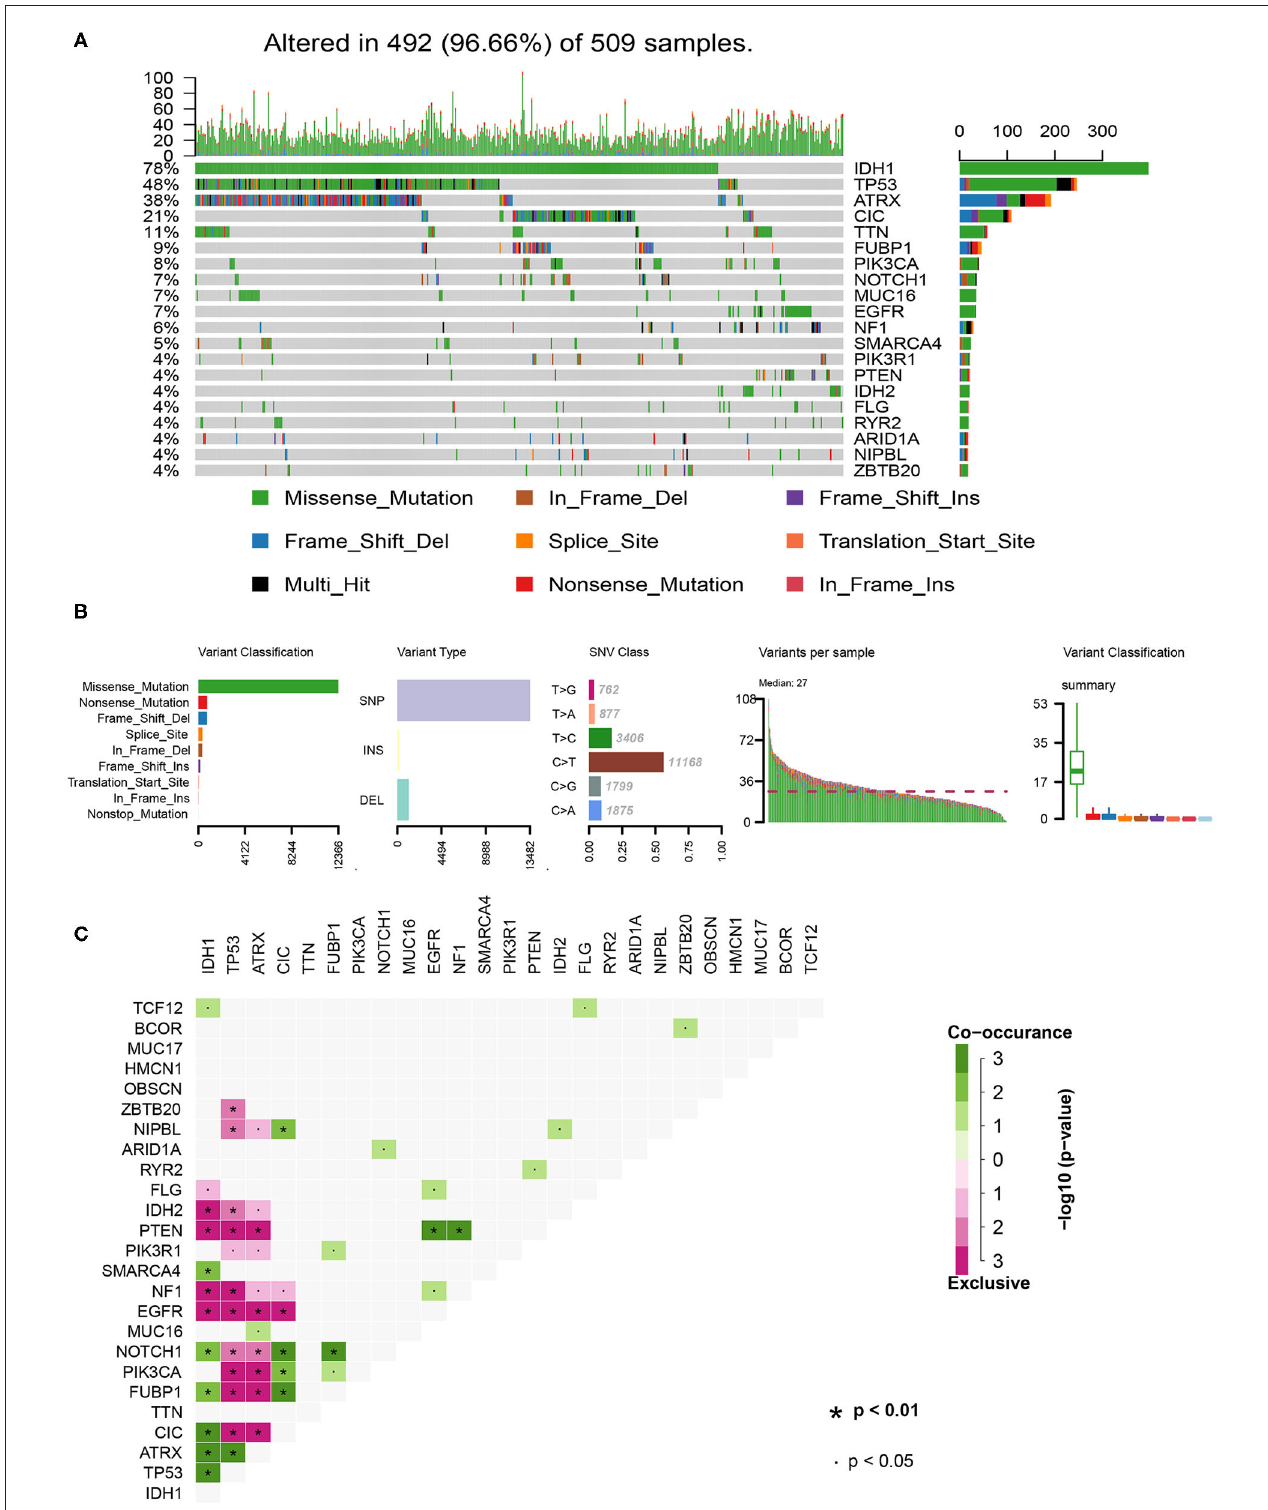
FIGURE 1 | Summary of the of LGG mutation information. (A) Landscape of mutation profiles in LGG samples. Waterfall plot showing the mutation information for each gene. Different colors represented the different mutation types. (B) Classification of mutation types according to different categories and tumor mutation burden in specific samples. (C) The coincident and exclusive associations across the top 25 mutated genes. SNP, single nucleotide polymorphism; SNV, single nucleotide variant.